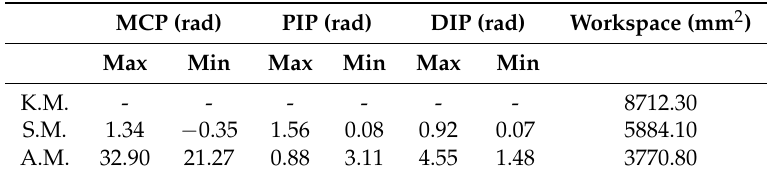
Table 2. Range of motion (ROM) and workspace of each motion. In the table, K.M. means kinematically possible motion, S.M. means spontaneous motion, and A.M. means assisted motion. Since concept of K.M. is only used in workspace analysis, the ROM of K.M. is